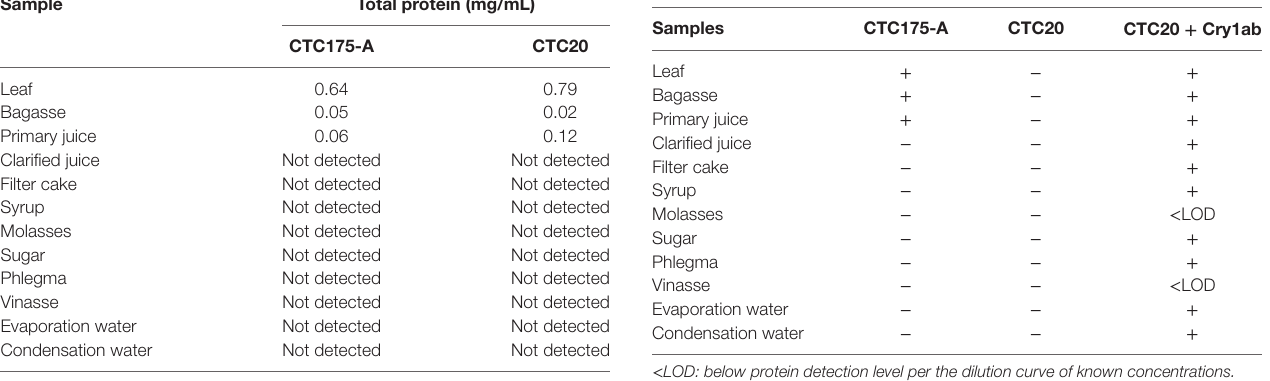
Single batch results (n = 1).